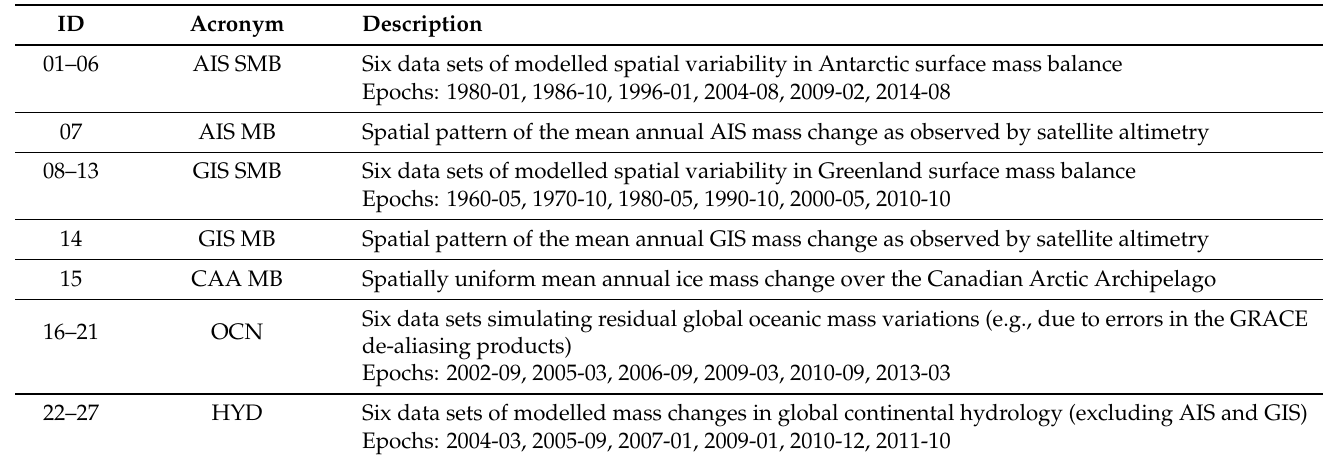
Table 1. Synthetic data sets used to assess signal leakage. Dates indicate the epochs selected from perennial model time